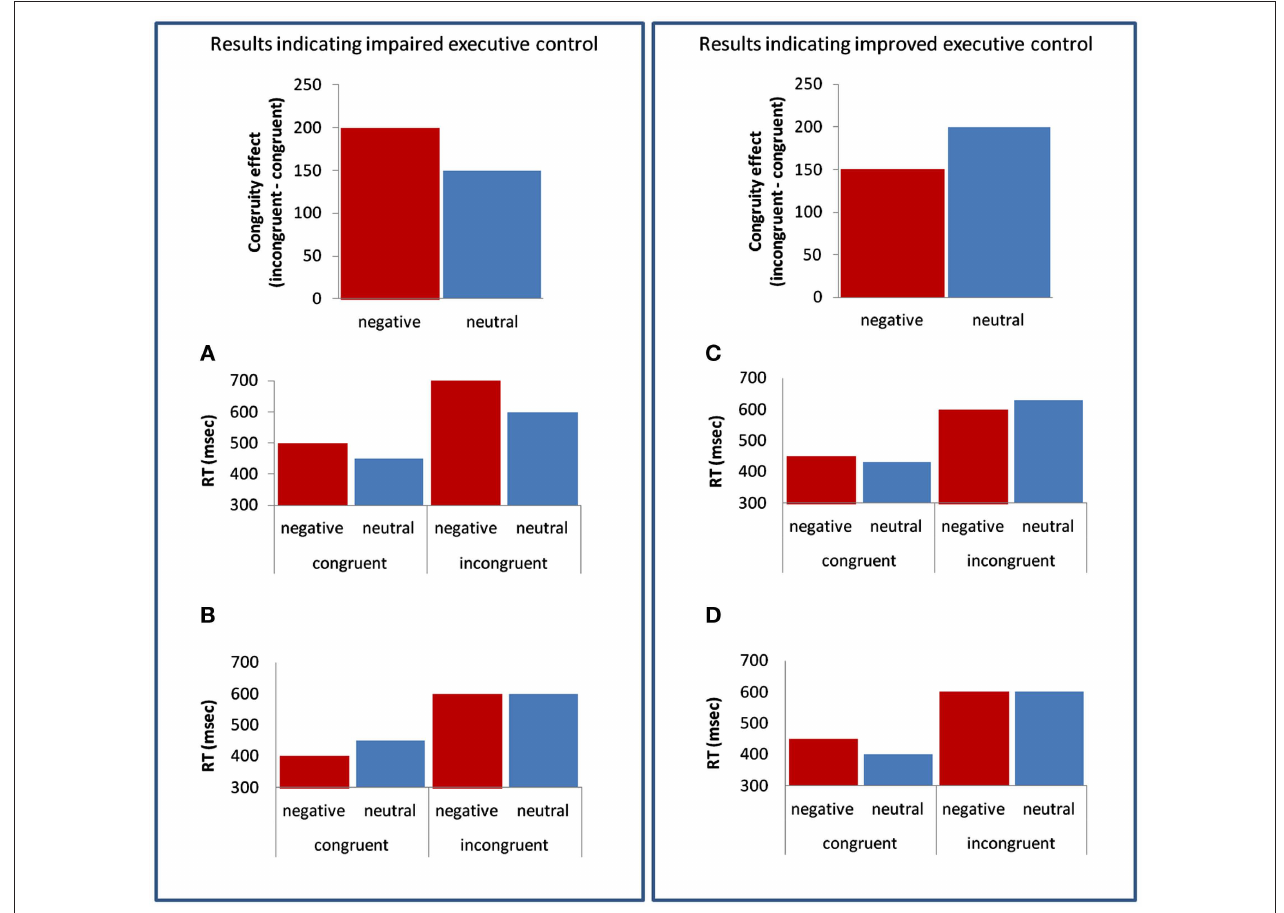
FIgure 1 | Illustration of “impaired” (A,B) and “improved” (C,D) executive control following negative, compared to neutral,